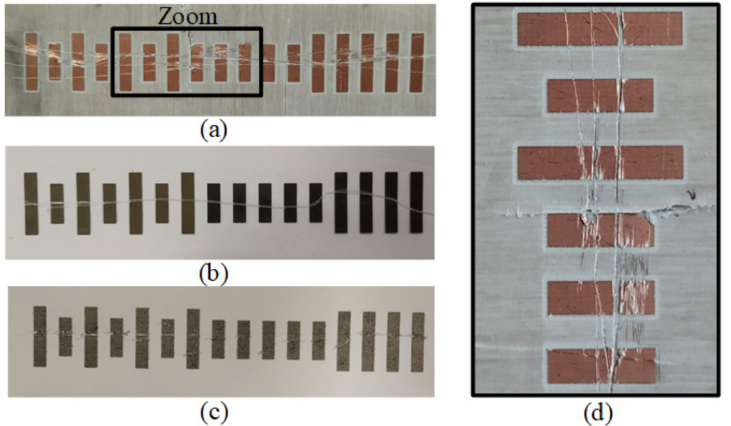
Figure 23. Photograph of the tags with deliberately generated cracks implemented on microwave substrate ( a ), plastic substrate ( b ), paper ( c ), and zoom view of cracked patches of the microwave substrate ( d ). Reprinted with permission from [26]. Copyright 2020 IEEE.